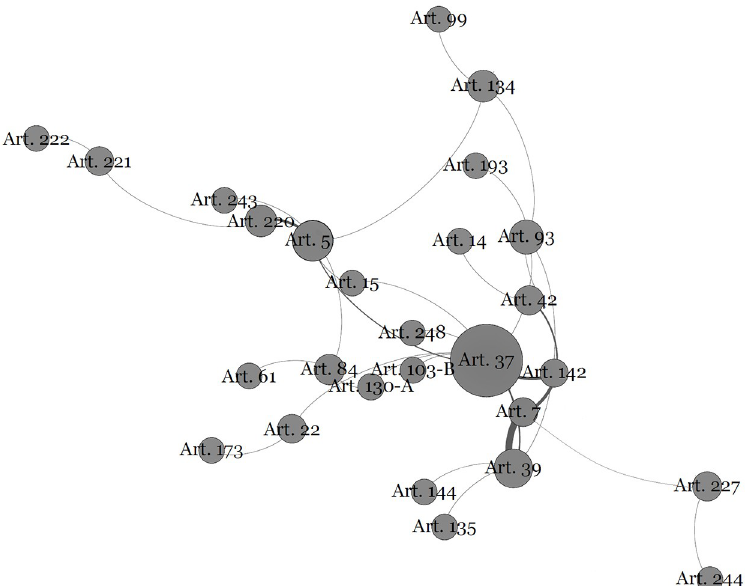
Fig 3. The public administration and its constitutional text